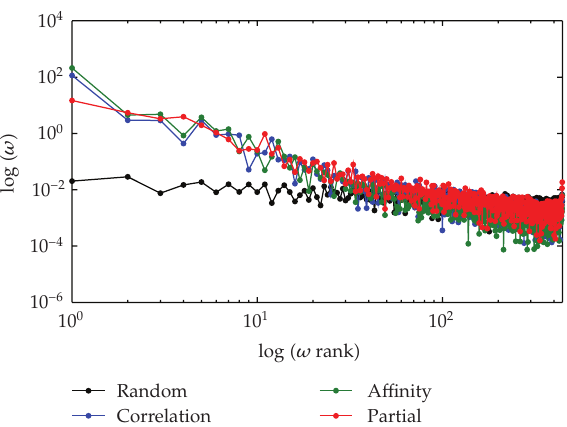
Figure 4: ω spectrum of the raw (cid:3) blue (cid:4) , a ffi nity (cid:3) green (cid:4) , and partial (cid:3) red (cid:4) correlation, in comparison with the corresponding random matrix (cid:3) black (cid:4) , for the S&P dataset.